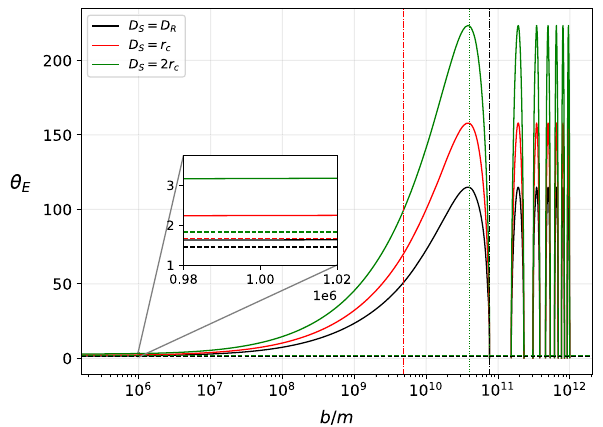
Fig. 8 The angular radius of the Einstein ring for SFDM profile in Sgr. A*